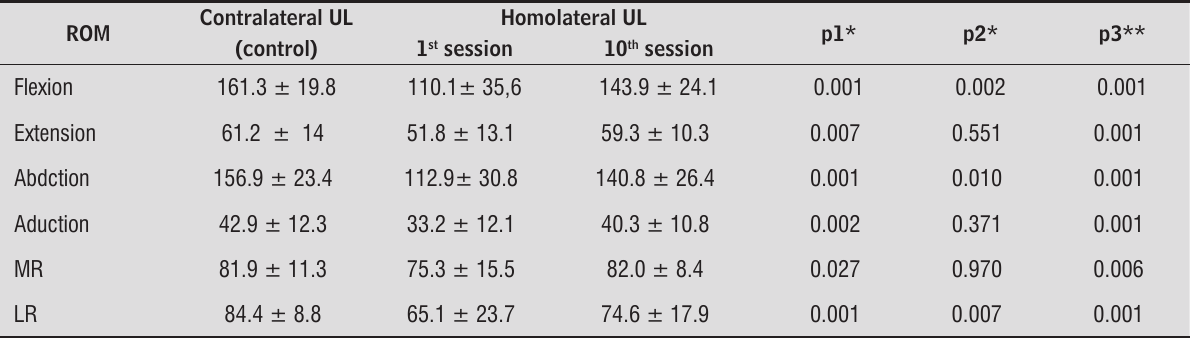
In addition, no meaningful correlation between ROM and DASH was found, except a weak and nega- tive one about extension movement and total score of DASH after 10 sessions (Table 4).